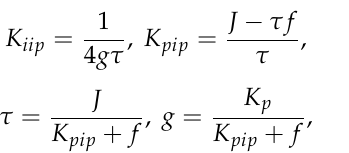
Table 2. Experimental and machine parameters.